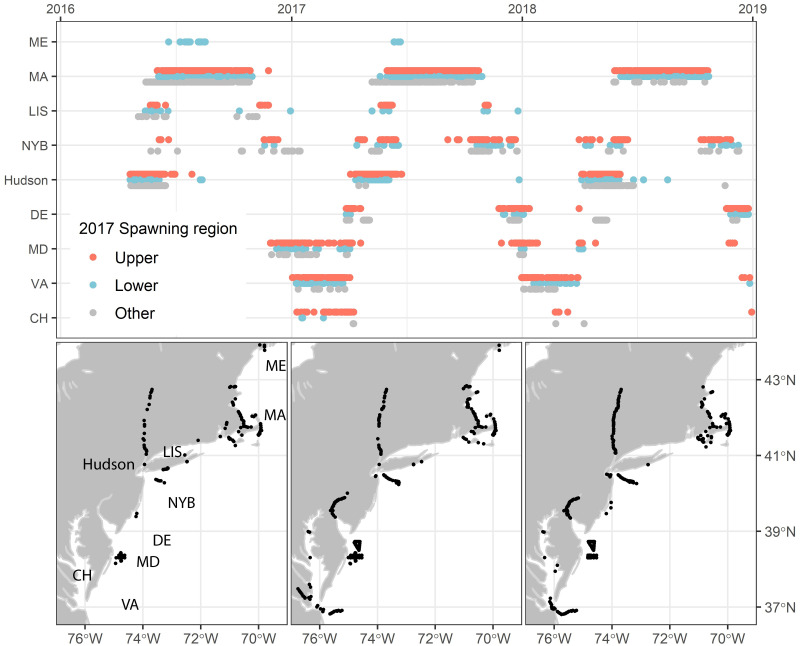
Atlantic shelf water telemetry detections of Hudson River striped bass spawning reach contingents.Top: Detections through time. Upper and Lower reach contingents are defined by clustering of 2017 spawning phenologies. The “Other” category are those not included in the 2017 classification owing to tag loss, skipped spawning, or straying. Detections are ordered by latitude of telemetry receiver array (Maine–Coastal Virginia/Chesapeake Bay). ME = Maine estuary and shelf waters, MA = Massachusetts and Cape Cod Bays, LIS = Long Island Sound, NYB (NY Bight) = New York and New Jersey shelf waters, Hudson = Hudson River Estuary; DE = Delaware River and shelf waters, MD = Maryland, VA = Virginia, CH = Chesapeake Bay. Bottom: Distribution of each year’s detections with regional identification of receiver arrays (left bottom panel).